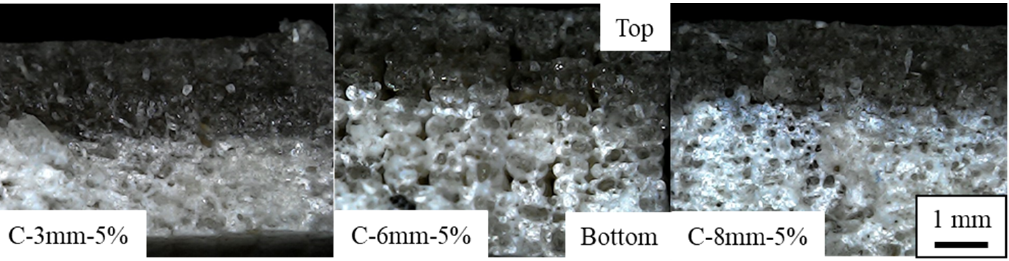
Figure 10. Representative failure modes of the 3D printed tensile specimens.